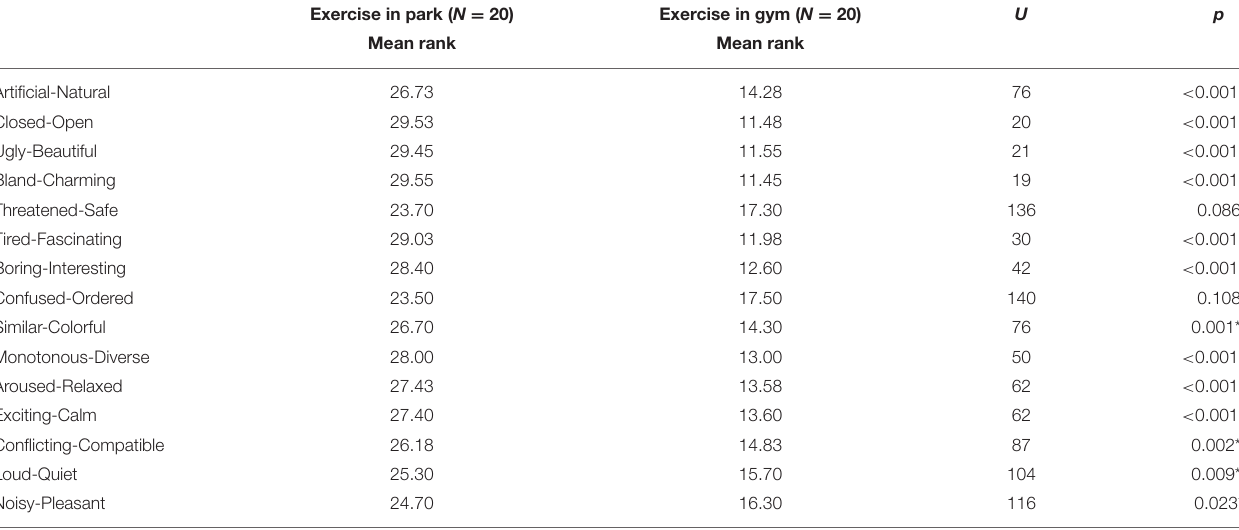
TABLE 6 | Comparison of environmental perceptions for different settings while walking slowly. Exercise in park ( N =